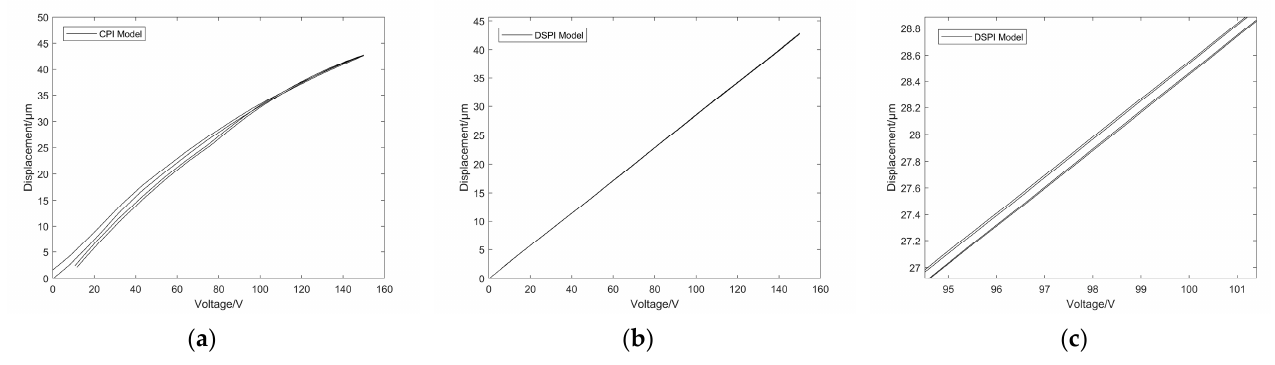
Figure 21. Comparison of the compensation control effect between the DSPI and CPI inverse models: ( a ) CPI inverse model; ( b ) DSPI inverse model; ( c ) local enlargement of ( b ).